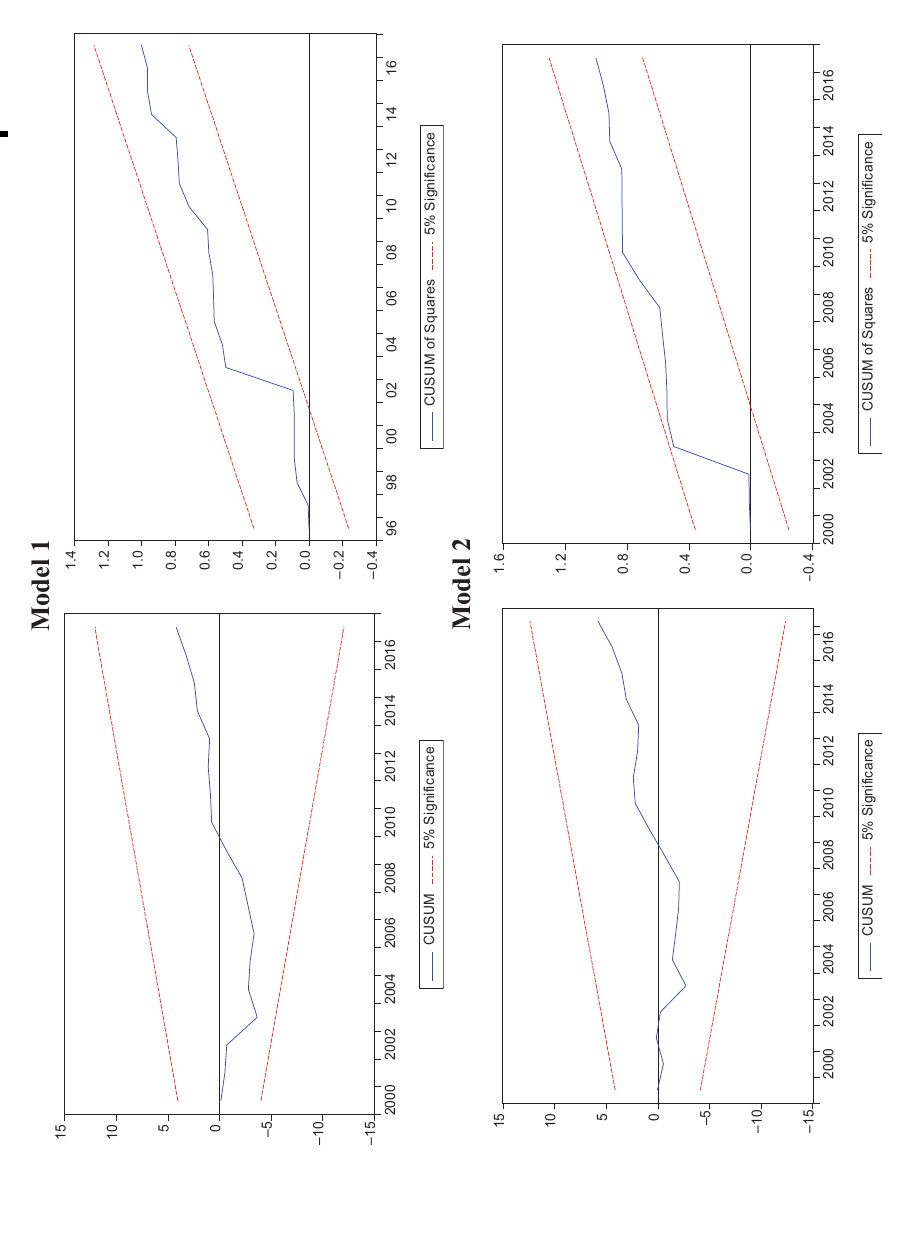
Figure 1. Stability